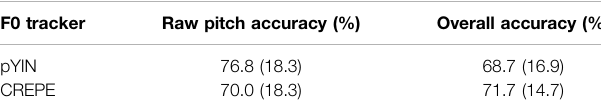
TABLE 7 | Results of the evaluation of monophonic F0 trackers on the ground truth unison mixtures. We use the reference melodic content as described in Section 3.2 . The results are averaged across songs and voice parts. Standard deviation is shown in